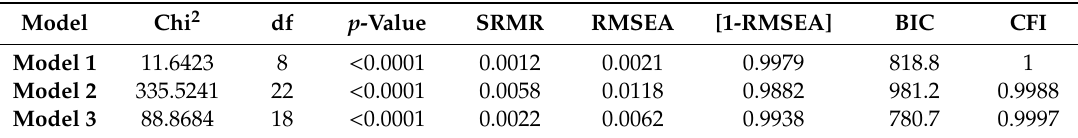
Table 2. Global fit measures for structural equation